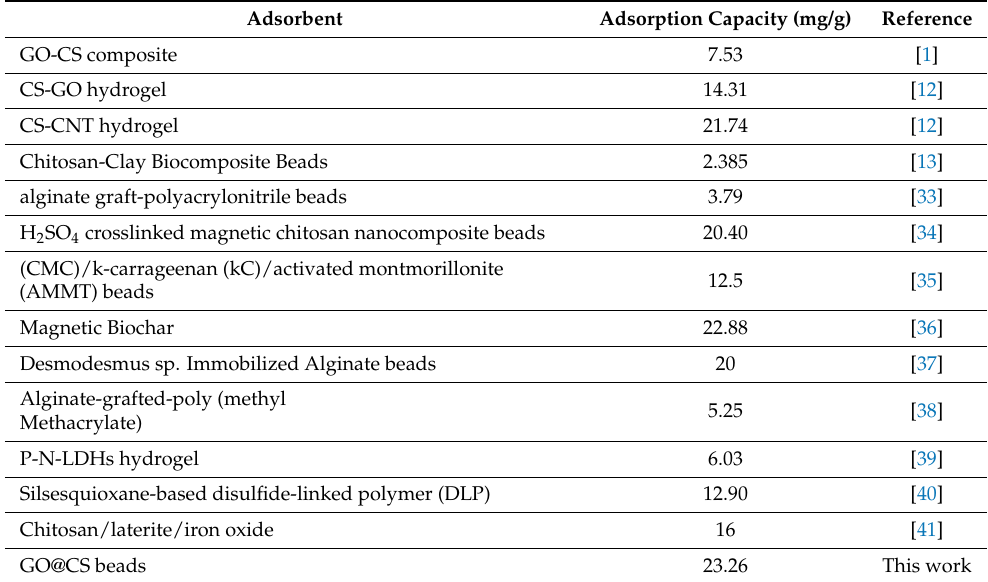
Table 3. Langmuir based maximum adsorption capacity of several adsorbents for MB-dye adsorption.